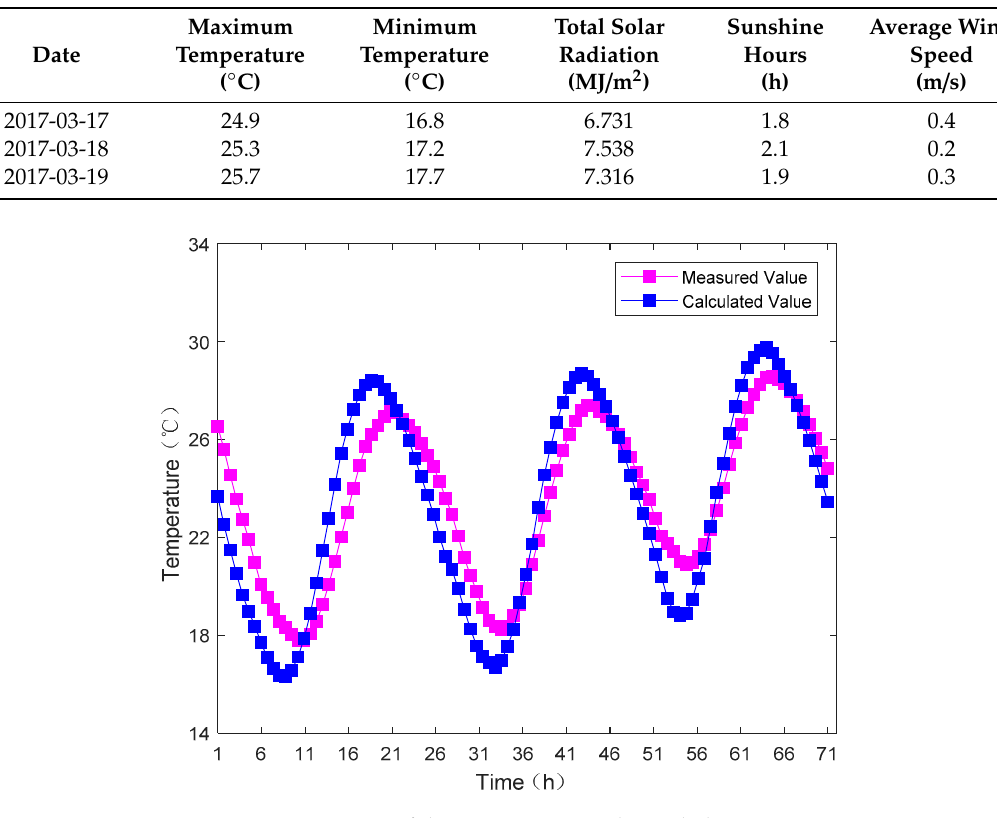
Figure 5. Comparison of the temperature in the asphalt pavement.